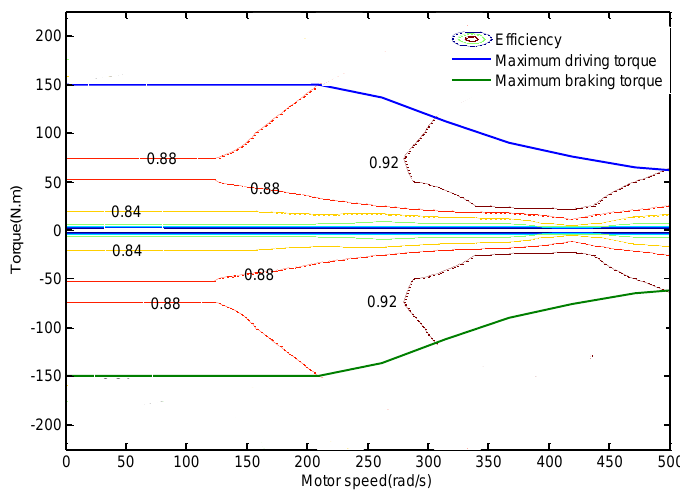
Figure 3. Motor torque-speed curve and efficiency